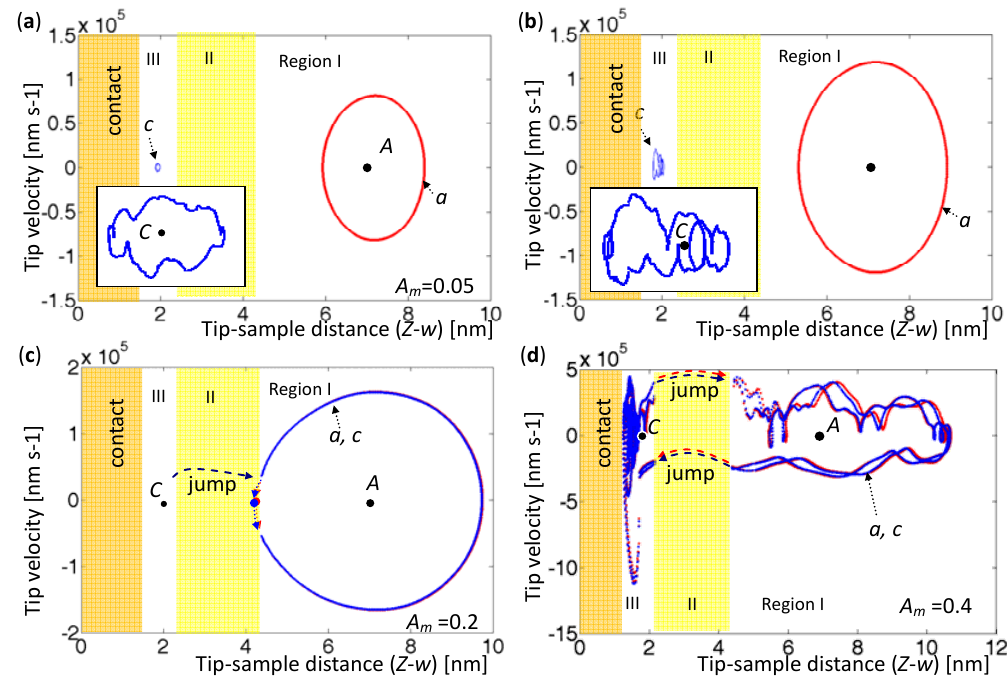
= 0.05 nm. ( b ) A = 0.09 m m